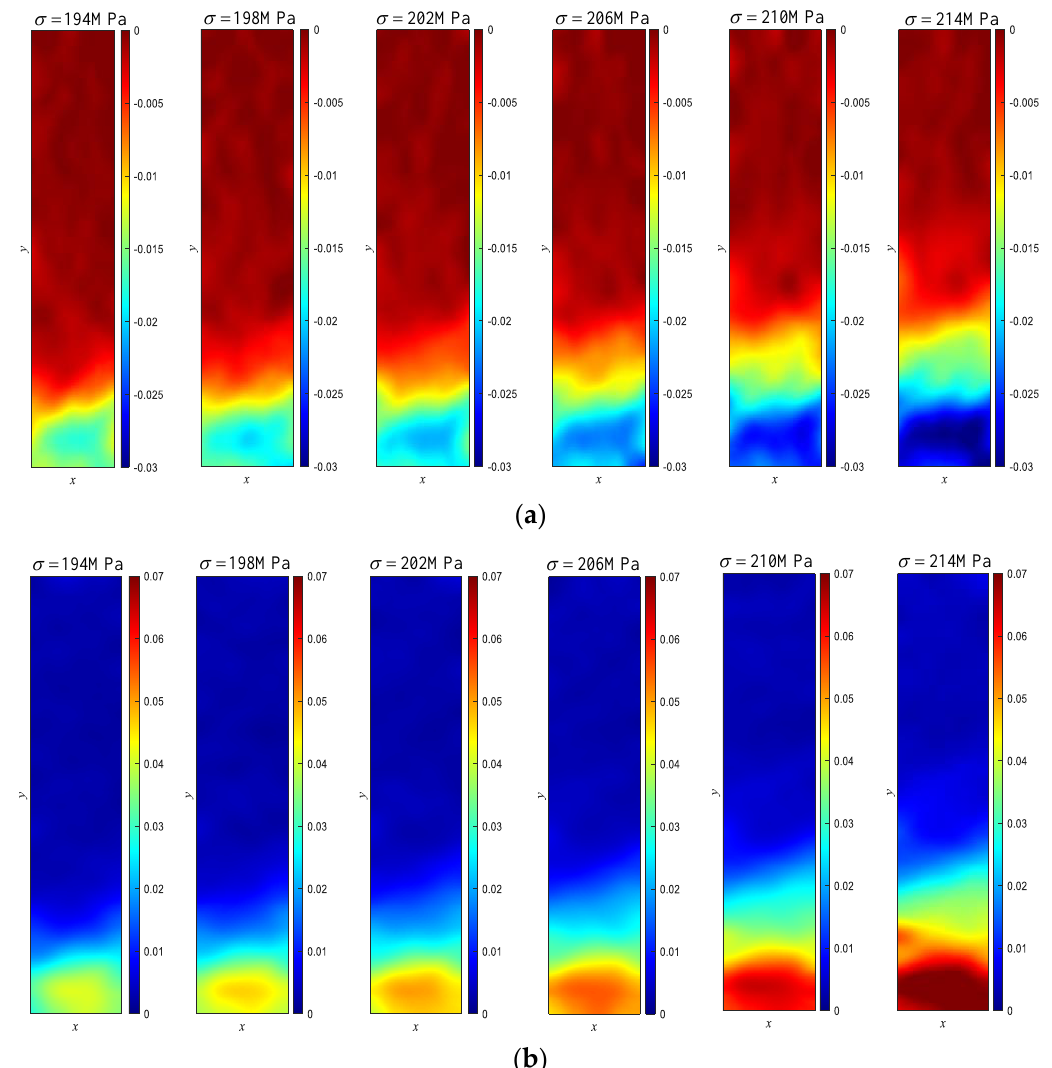
Figure 9. The distribution of strain on the specimen surface under different stress conditions: ( a ) the transverse strain; ( b ) the longitudinal strain.